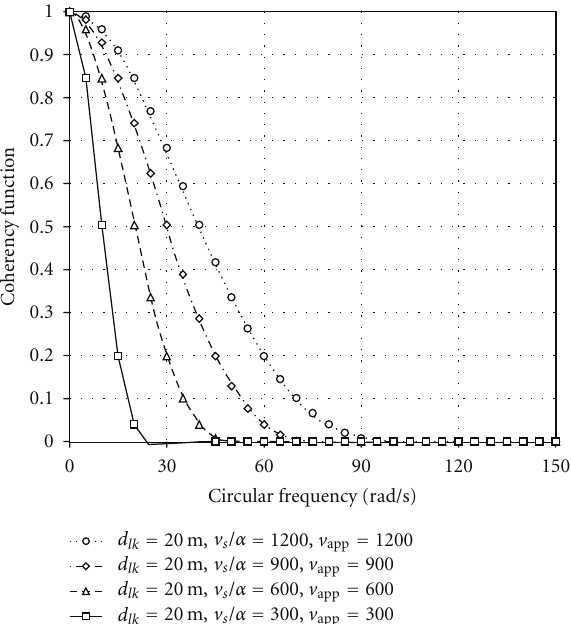
Figure 10: Coherency function modulus obtained for di ff erent correlation levels corresponding to a set of 4 values of parameters /α e v v s app (formulation by Luco and Wong).